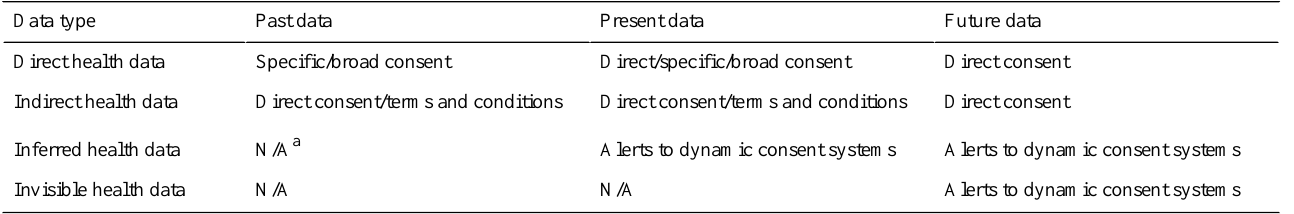
Table 2. Consent based on different health data types related to their temporal